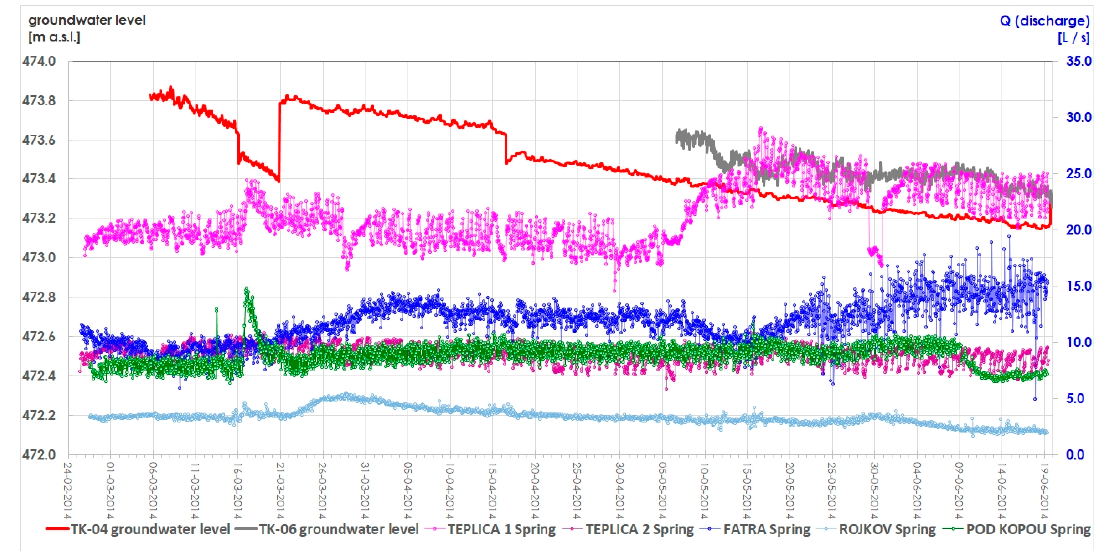
Figure 7. Groundwater levels in TK-04 and TK-06 boreholes and discharges of the Kopa Mt. aquifer karstic springs in the period 24.02.2014–20.06.2014.